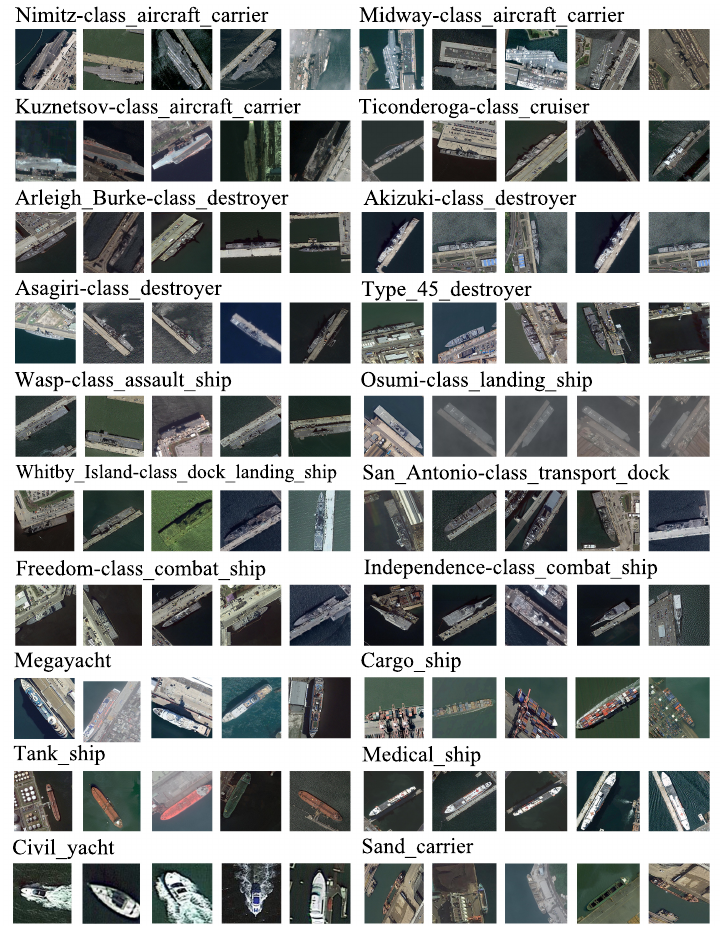
Figure 3. FGSCR-42 Example images with annotation